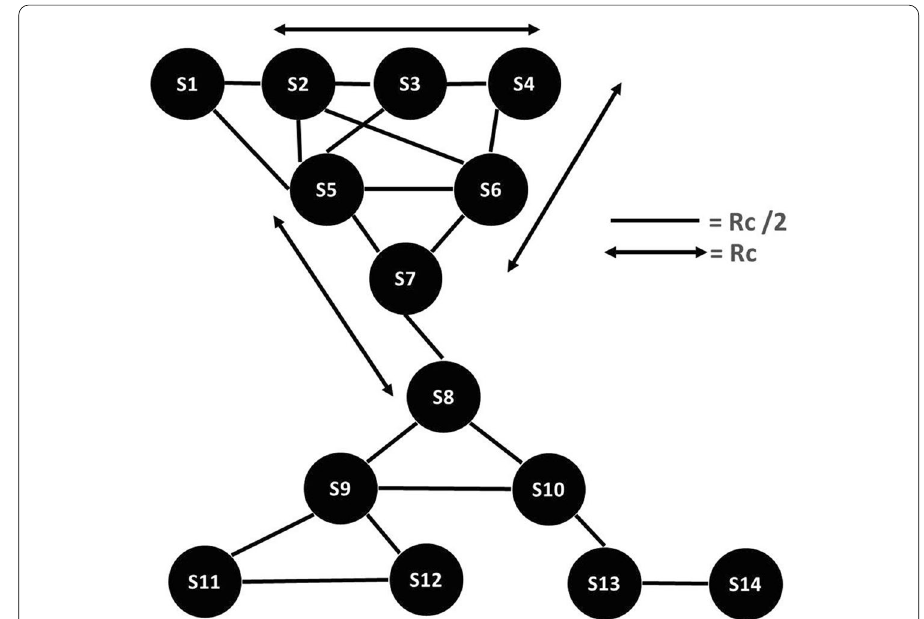
Fig. 1 Network topology after initial